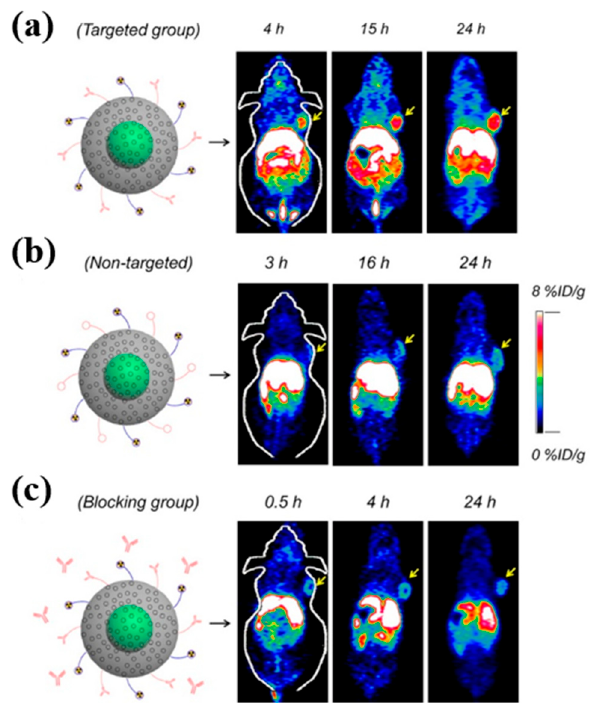
Figure 5. In vivo serial coronal PET images of ( a ) 64 Cu-CuS@MSN-TRC105 nanoconjugates (targeted group), ( b ) 64 Cu-CuS@MSN (non-targeted group), and ( c ) 64 Cu-CuS@MSN-TRC105 with a large dose of free TRC105 (blocking group) in 4T1 murine breast tumor-bearing mice at different time points postinjection. Reprinted with permission from Reference [101]. Copyright 2015 American Chemical Society.